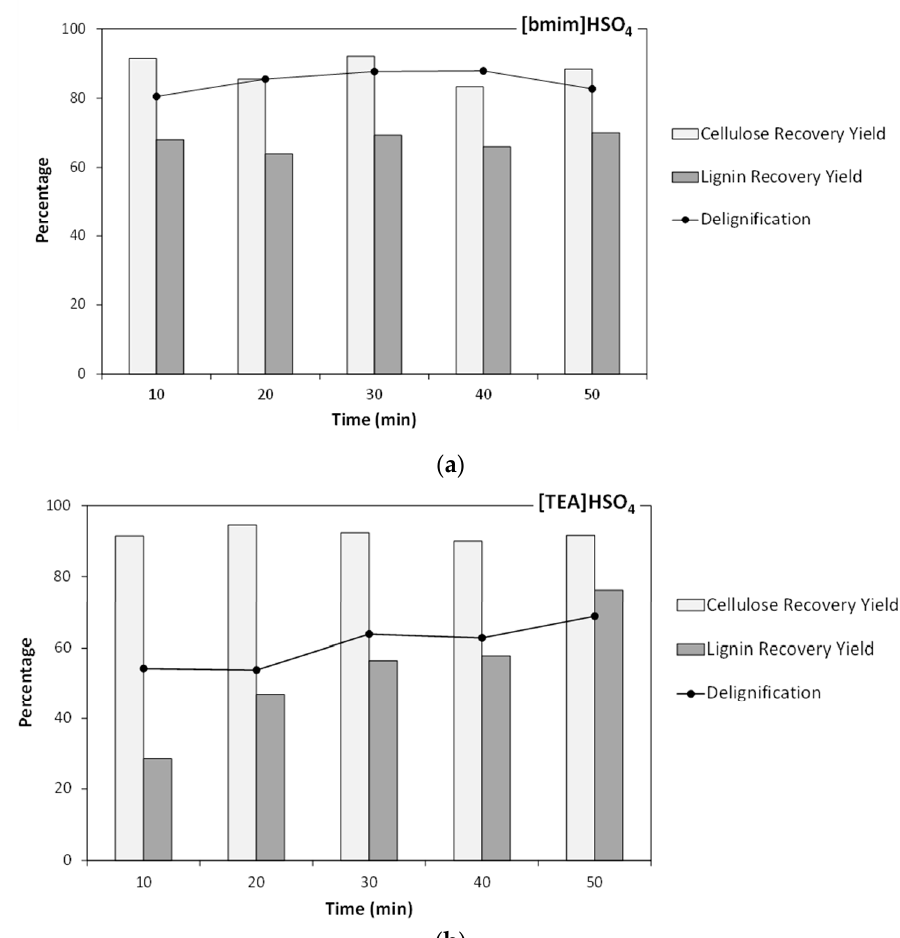
Figure 2. Results obtained in delignification treatments carried out at 170 °C using: ( a ) [bmim]HSO 4 , and ( b ) [TEA]HSO 4 .